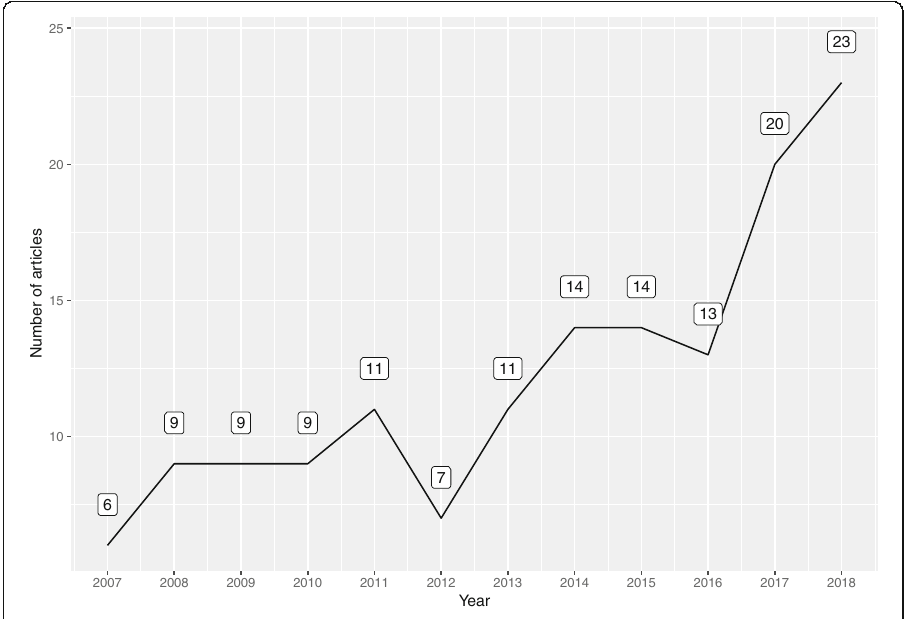
Fig. 2 Number of included articles per year ( n = 146)